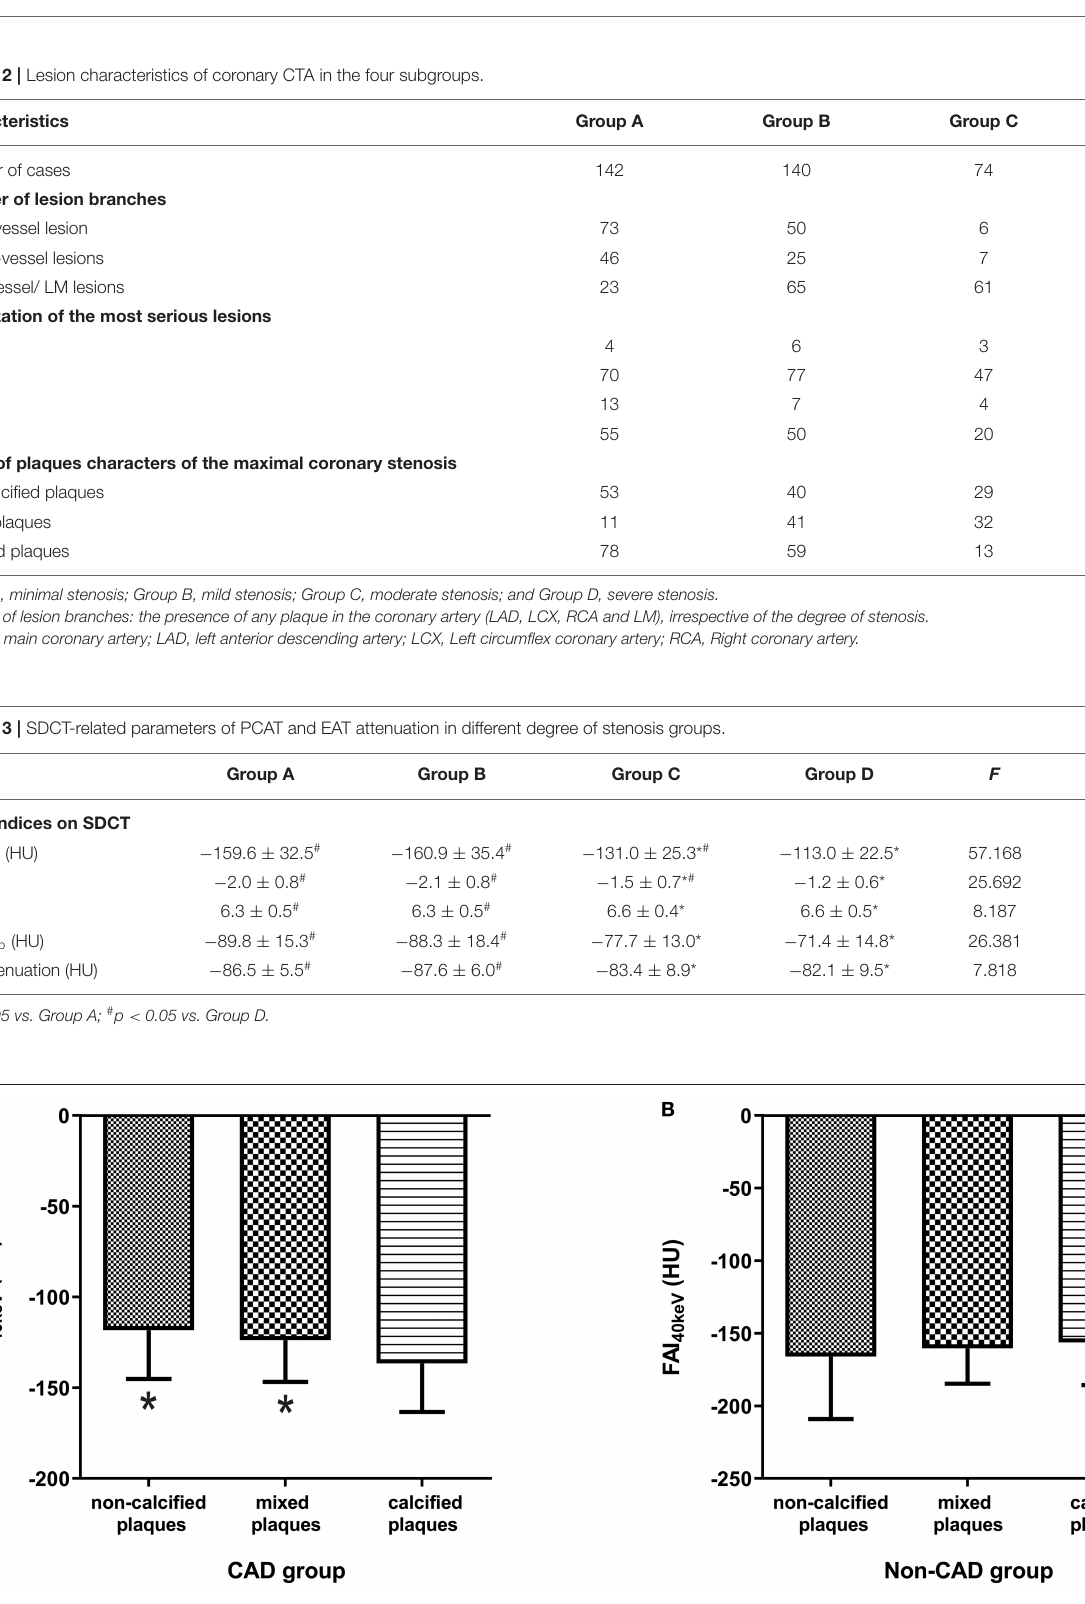
FIGURE 4 | Comparison of FAI40keV (HU) based on plaque type in CAD group (A) and non-CAD group (B) . * p < 0.05 compared to calcified plaques.